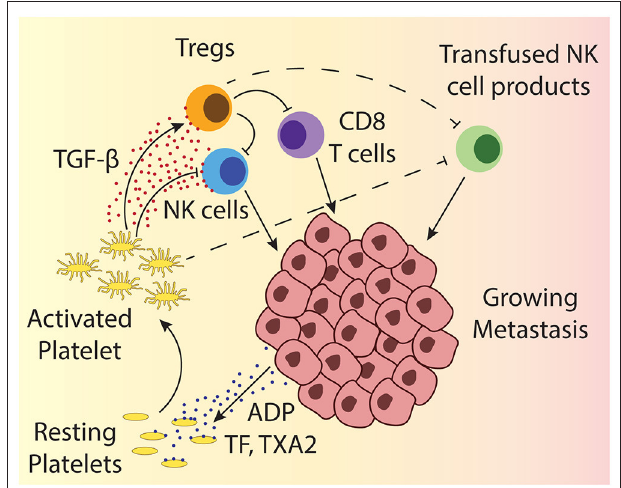
FIGURE 2 | Depicted is a growing metastasis, highlighting the interactions between platelets and different lymphocytes. Tumor cells can activate platelets through release of ADP and TF. ADP directly activates platelets through engagement of the ADP receptor, while TF activates platelets together with other coagulation factors. Platelet activation results in the release of the dense granules and α -granules that contain amongst others more ADP, different clotting factors, growth factors, and TGF- β , which can impact different tumor infiltrating lymphocytes. The impact of TGF- β on T cells and NK cells is indicated by solid line arrows and the suspected impact on transfused cellular therapy products is shown by dashed line arrows.